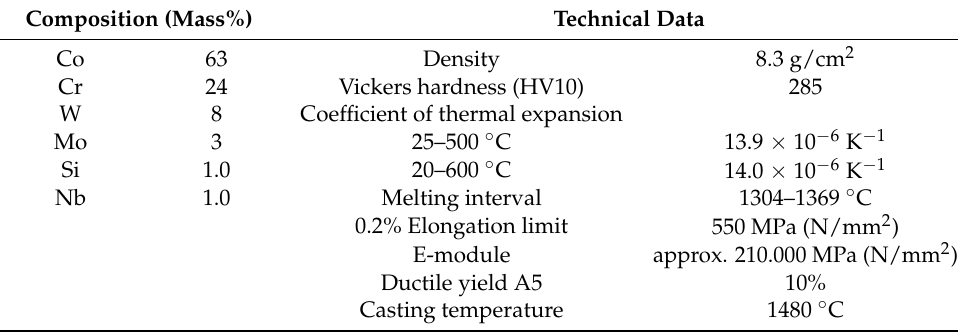
Table 1. Chemical composition and properties of the CoCr alloy.